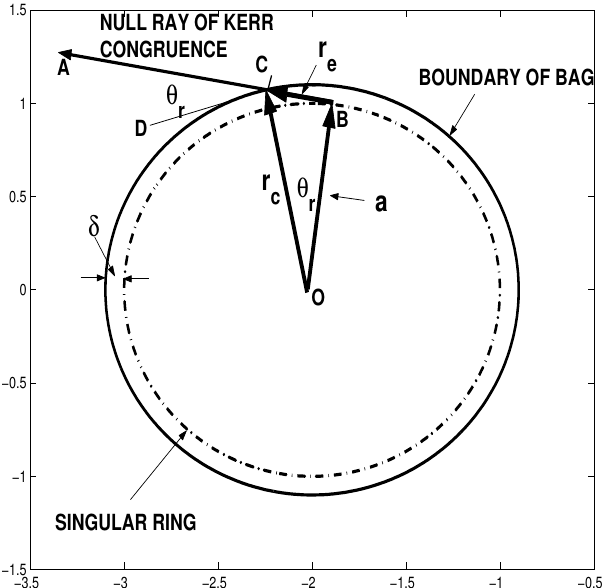
Figure 3. Kinematic relations for the KN disk in equatorial plane. Null rays of Kerr congruence k ± are tangent to Kerr singular ring and cross border of bag at angle θ r = arctan r e / a ≈ α